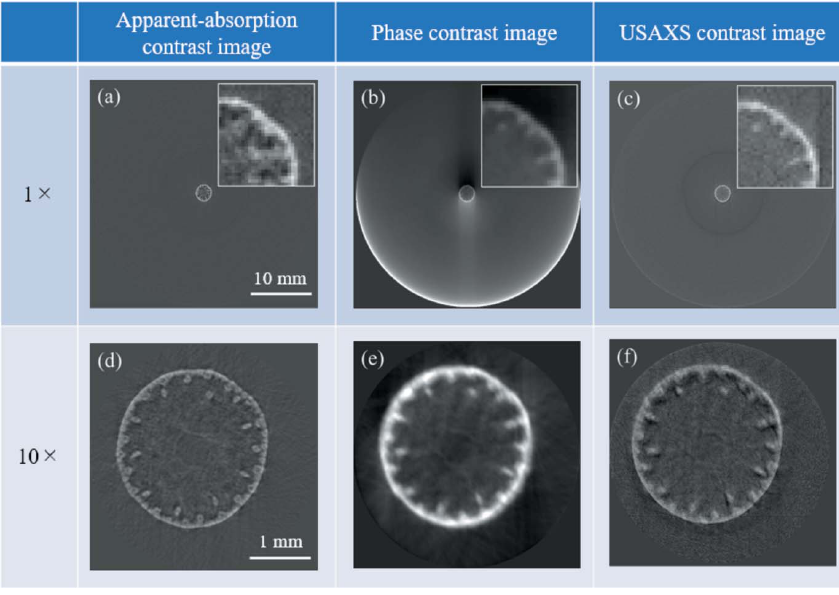
Figure 4 Reconstructed slice images of the stem of Japanese pampas grass ( Miscanthus sinensis ), the diameter of which is about 2.3 mm. The images on the left [( a ) and ( d )], center [( b ) and ( e )] and right [( c ) and ( f )] columns are the apparent-absorption contrast, phase contrast and USAXS contrast images, respectively. The magnification factor is M = 1 for the images in the top row [( a )– ( c )], and M = 10 for those in the bottom row [( d )–( f )]. For comparison, the insets in ( a )–( c ) show digital zoom (10 (cid:3) ) images of the upper-right part of the slice images of the sample.